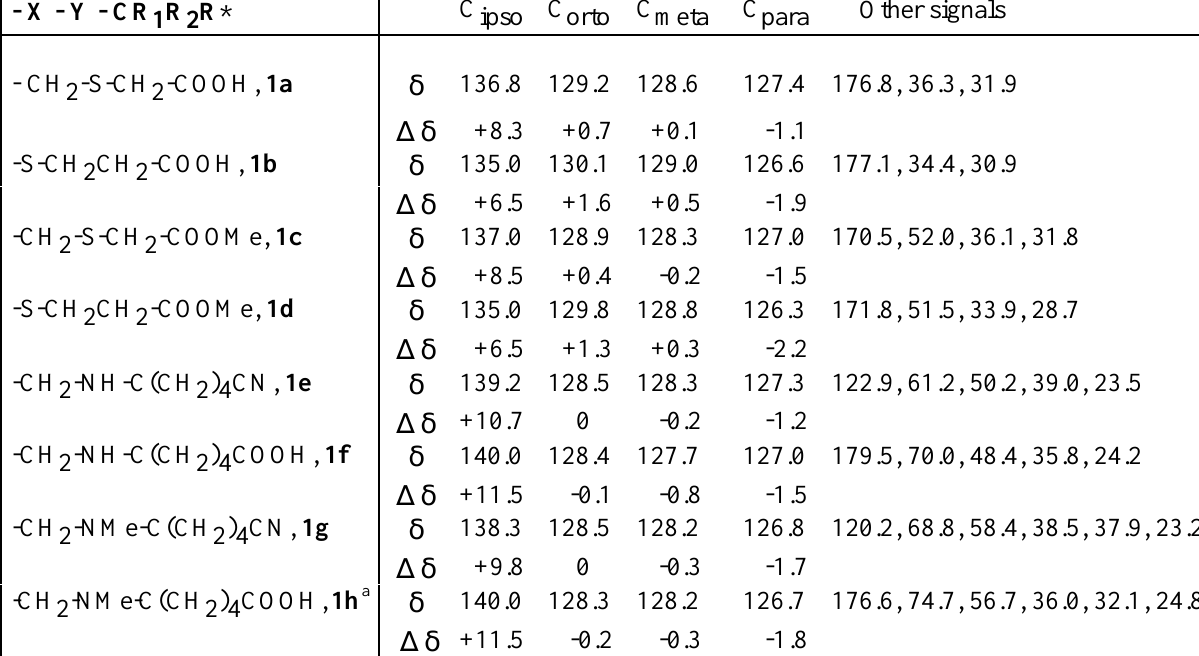
Table 2. Chemical shifts ( d , in ppm) and substituent chemical shifts (